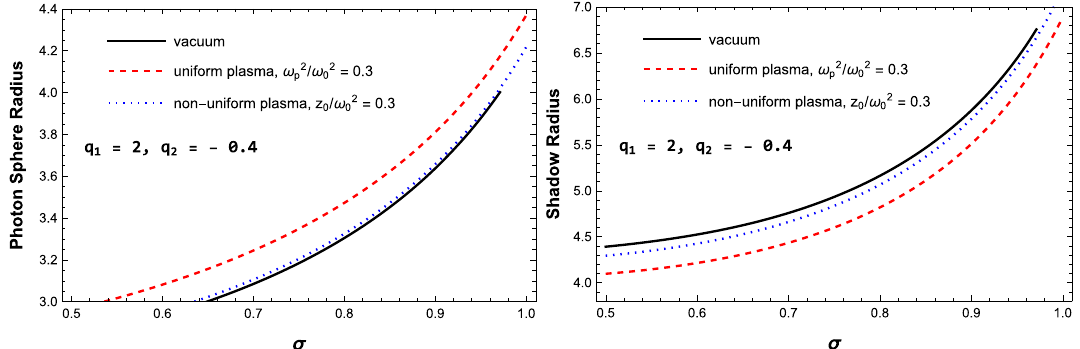
Fig. 12 Comparing photon sphere and shadow radius for vacuum, uniform plasma, and non-uniform plasma. The solid black lines, dashed red lines and dotted blue lines correspond to vacuum, uniform plasma, and non-uniform plasma cases, respectively